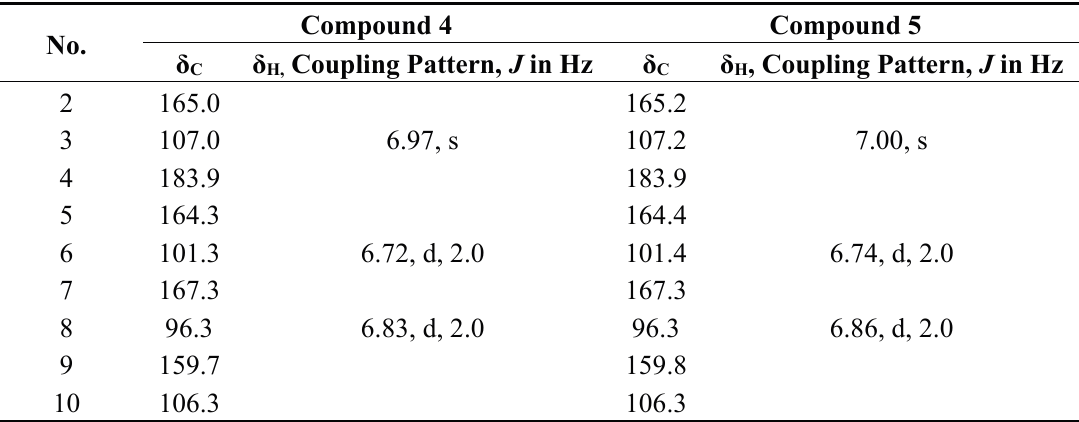
Table 1. 1 H- (400 MHz) and 13 C-NMR (100 MHz) data of compound 4 – 5 (in pyridine- d 5 , δ in ppm, J in